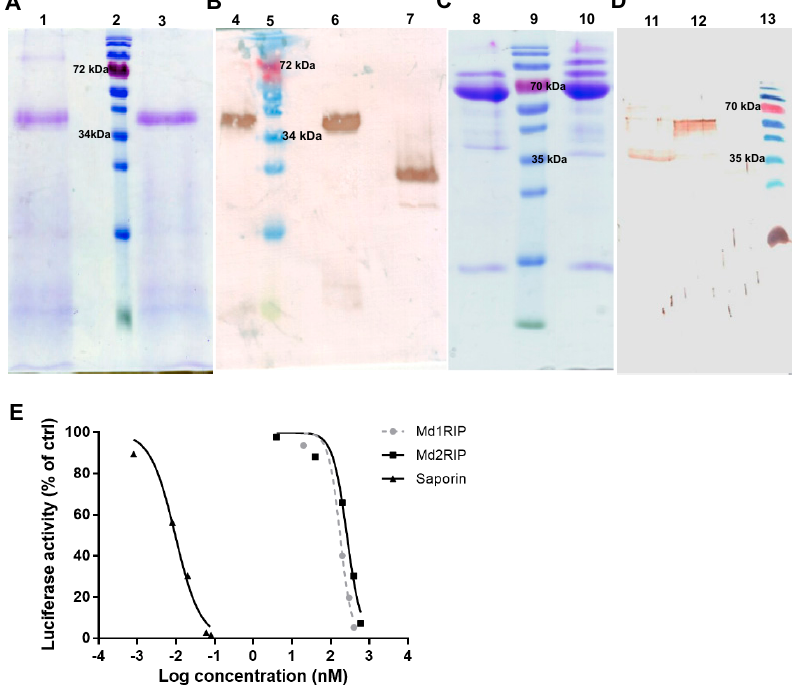
Figure 2. SDS-PAGE ( A , C ) and Western blot analysis ( B , D ) of recombinant MdRIPs. Lanes 1 and 4: unreduced Md1RIP, lanes 3 and lane 6: reduced Md1RIP treated with β -mercaptoethanol, lane 7: positive control (Orysata, [23]), lanes 8 and 12: reduced Md2RIP, lane 10: unreduced Md2RIP, lane 11: positive control (Md1RIP). In panels A and B 5 µg protein was loaded in each well. In panels C and D 15 µg and 3 µg protein were loaded, respectively. Protein ladder (Fermentas) was run in lanes 2, 5, 9, and 13; ( E ) Effect of RIPs in a cell-free translation assay. Dose response curves for luciferase synthesis were measured after treatment with increasing concentrations of Md1RIP, Md2RIP, and saporin for 30 min. Luciferase activity is shown as a function of the concentration of Md1RIP and Md2RIP. SDS-PAGE analysis (Figure 2C) of recombinant Md2RIP yielded a major polypeptide band of 65.5 kDa. The size of these polypeptides is approximately 4 kDa higher than the calculated molecular mass of the Md2RIP coding sequence (61.5 kDa, RIP and lectin domain containing a (His) 6 tag). Western blot analysis using a polyclonal antibody against the Md1RIP confirmed that the 65.5 kDa polypeptide reacts with the RIP antibody (Figure 2D). Edman degradation of the 65.5 kDa polypeptide yielded the sequence of GATAXXDIXXL (Figure S4 in the Supplementary Materials), which suggested that, besides the signal peptide, an extra propeptide of 27 amino acid residues is cleaved at the N -terminus of the recombinant Md2RIP secreted to the BY-2 cell medium.